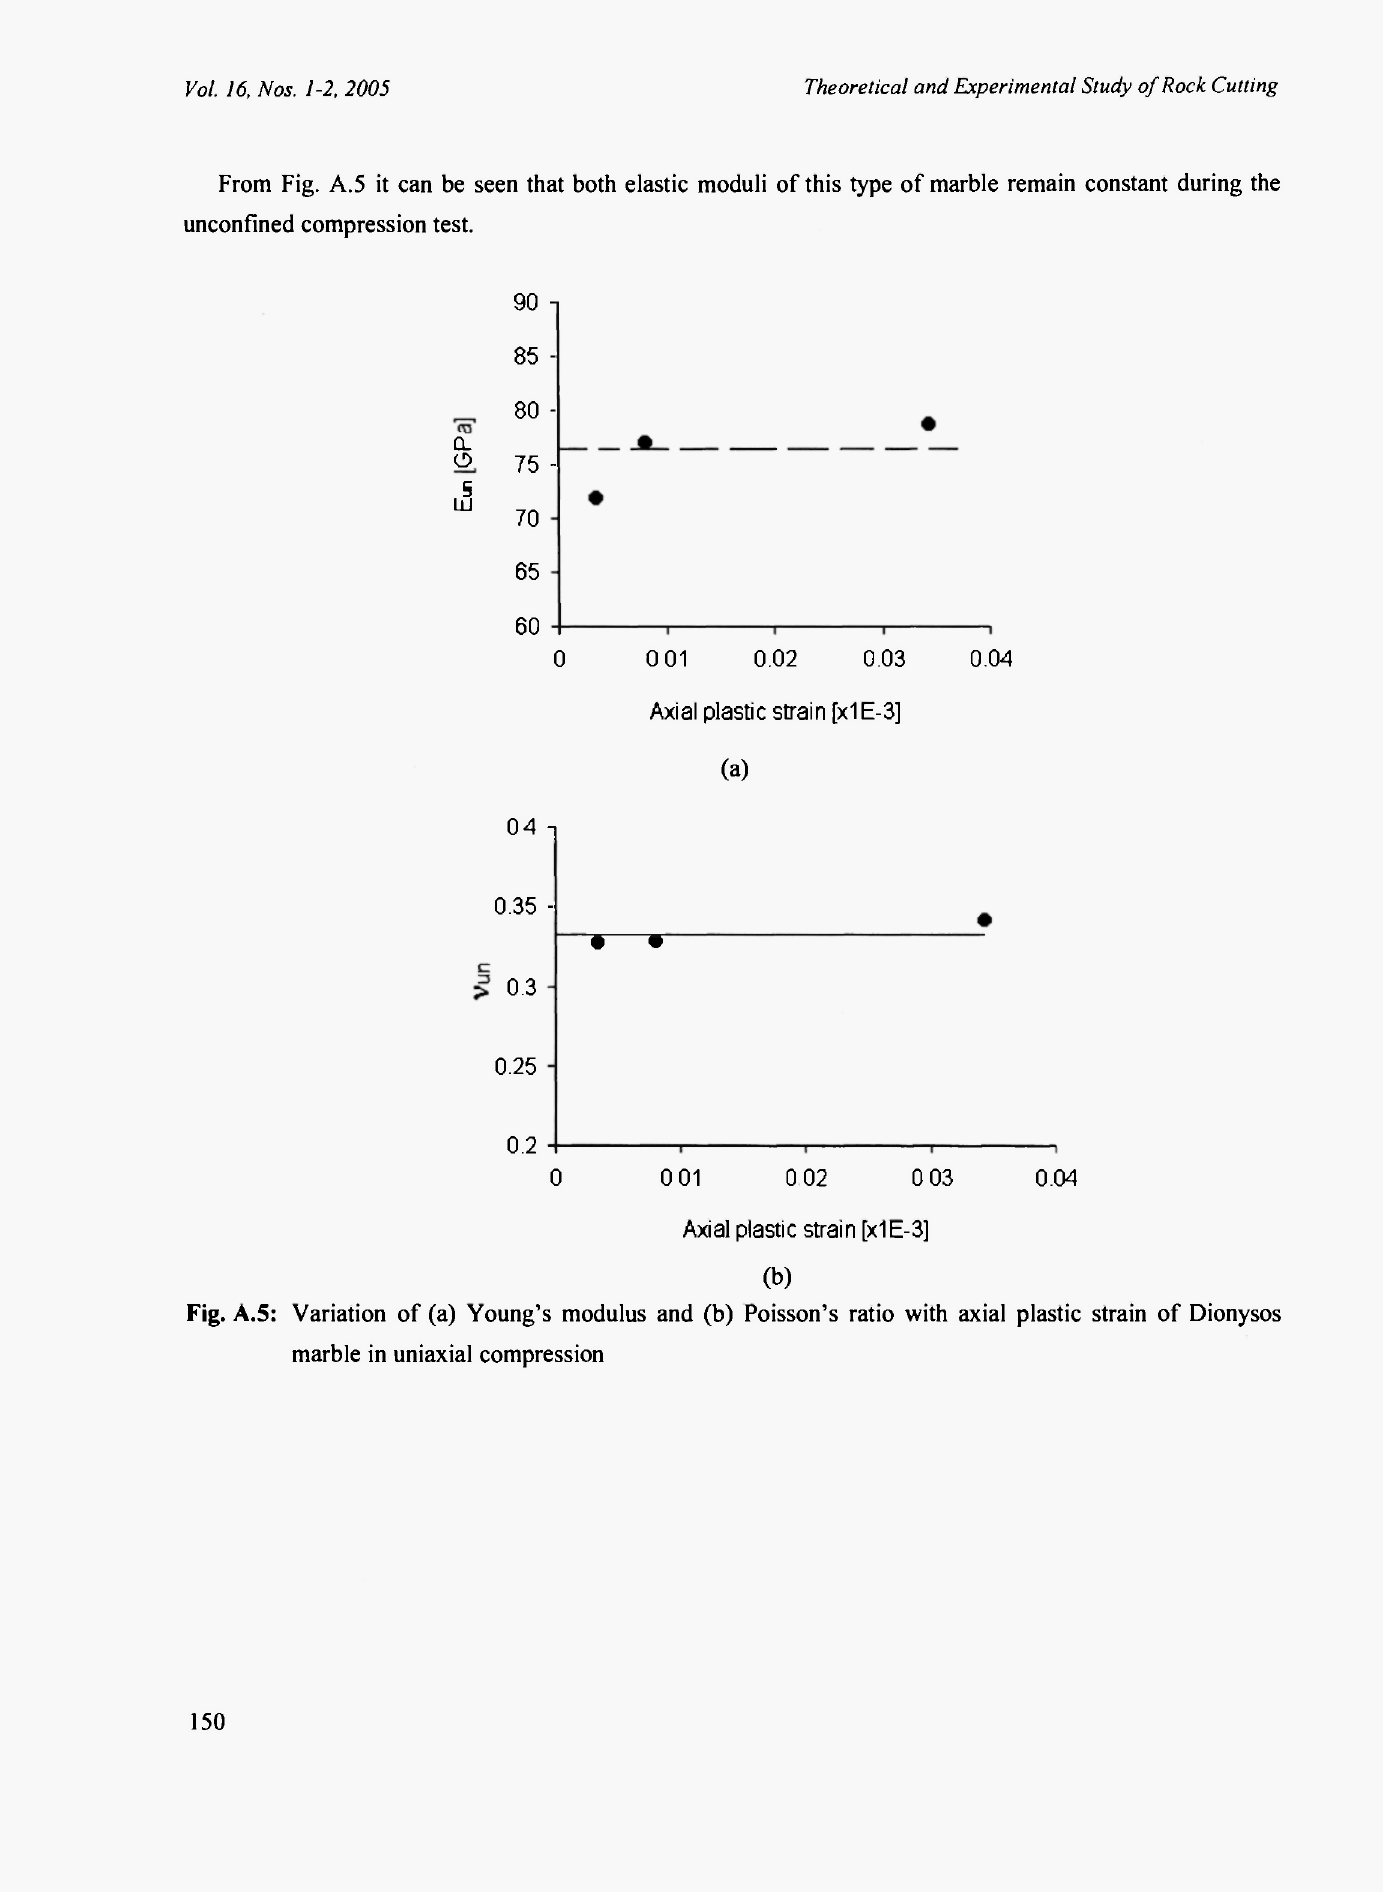
Fig. A.5: Variation of (a) Young's modulus and (b) Poisson's ratio with axial plastic strain of